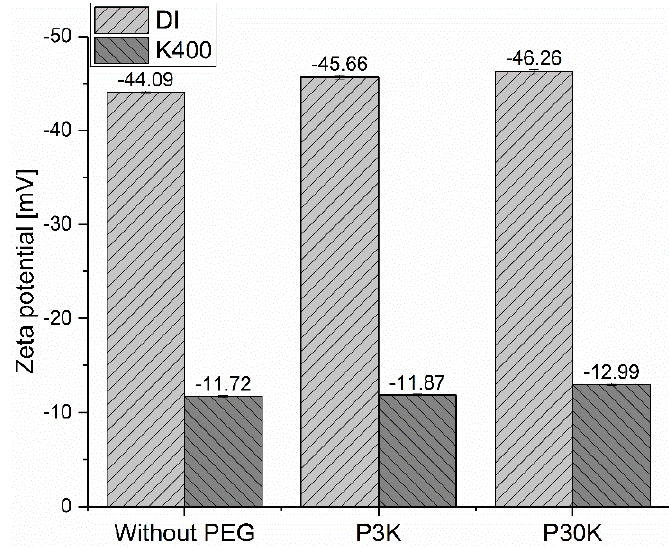
Figure 7. Zeta potential of GBS with the addition of di ff erent PEGs.